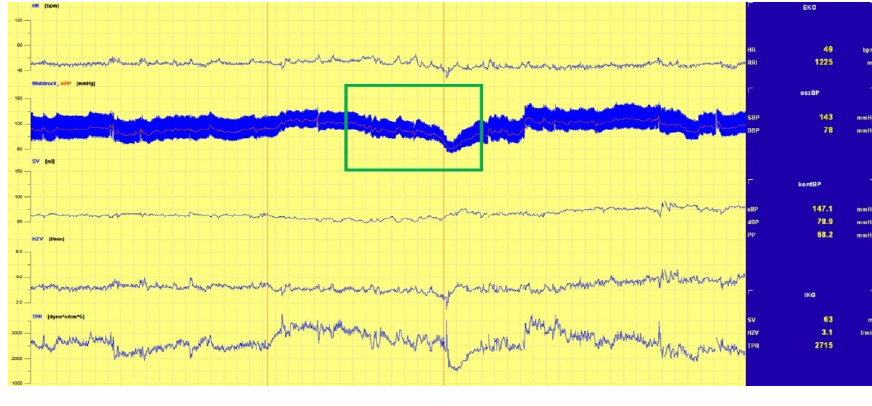
Figure 4. Continuous Drop in